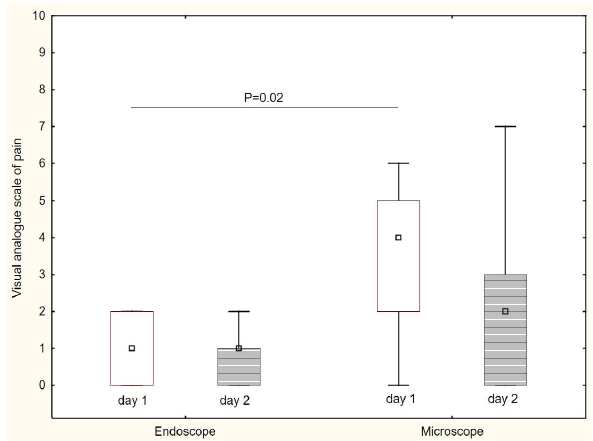
Fig. 3. A comparison of visual analogue scale of pain intensity after endoscopic and microscopic ear procedures in grade 1 cholesteatoma